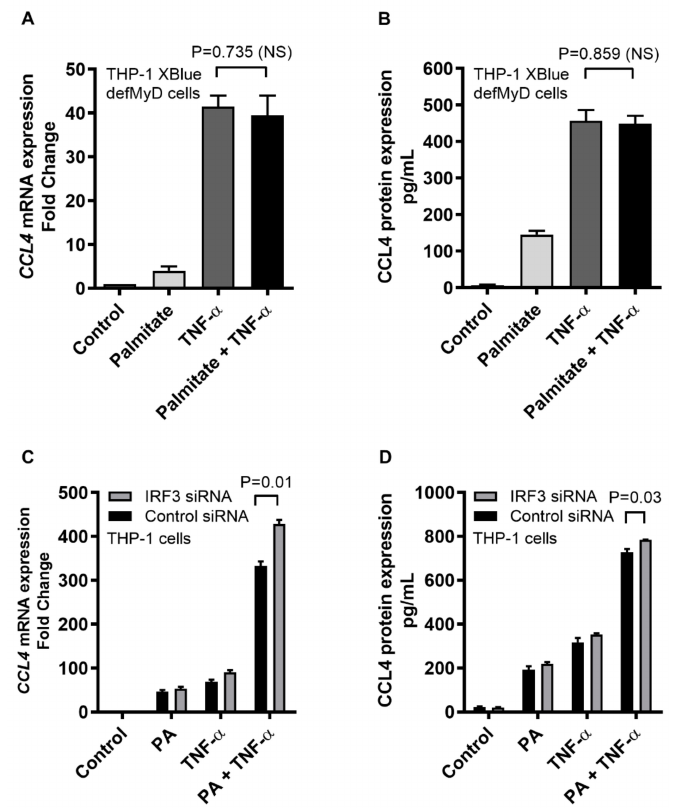
Figure 4. TNF- α / palmitate cooperativity for CCL4 induction is MyD88 dependent. To determine whether the MyD88 adaptor protein was required for the cooperative CCL4 expression, MyD88-deficient THP1-XBlue-defMyD cells were co-stimulated with TNF- α / palmitate. The data (mean ± SEM) show that the co-induction e ff ect was lost in MyD88 − / − cells as TNF- α / palmitate co-stimulation induced similar expression of ( A ) CCL4 mRNA ( p = 0.735) and ( B ) CCL4 secreted protein ( p = 0.859) as compared to treatment with TNF- α alone. In parallel, IRF3 silencing was carried out as described in the materials and methods section and the data (mean ± SEM) show that IRF3 ablation did not downmodulate the expression of ( C ) CCL4 mRNA and ( D ) CCL4 secreted protein in IRF3-ablated cells compared to the control (scrambled siRNA-transfected cells). Together, these results support that the co-induction of CCL4 by TNF- α / palmitate in human monocytic cells is MyD88 dependent or IRF3